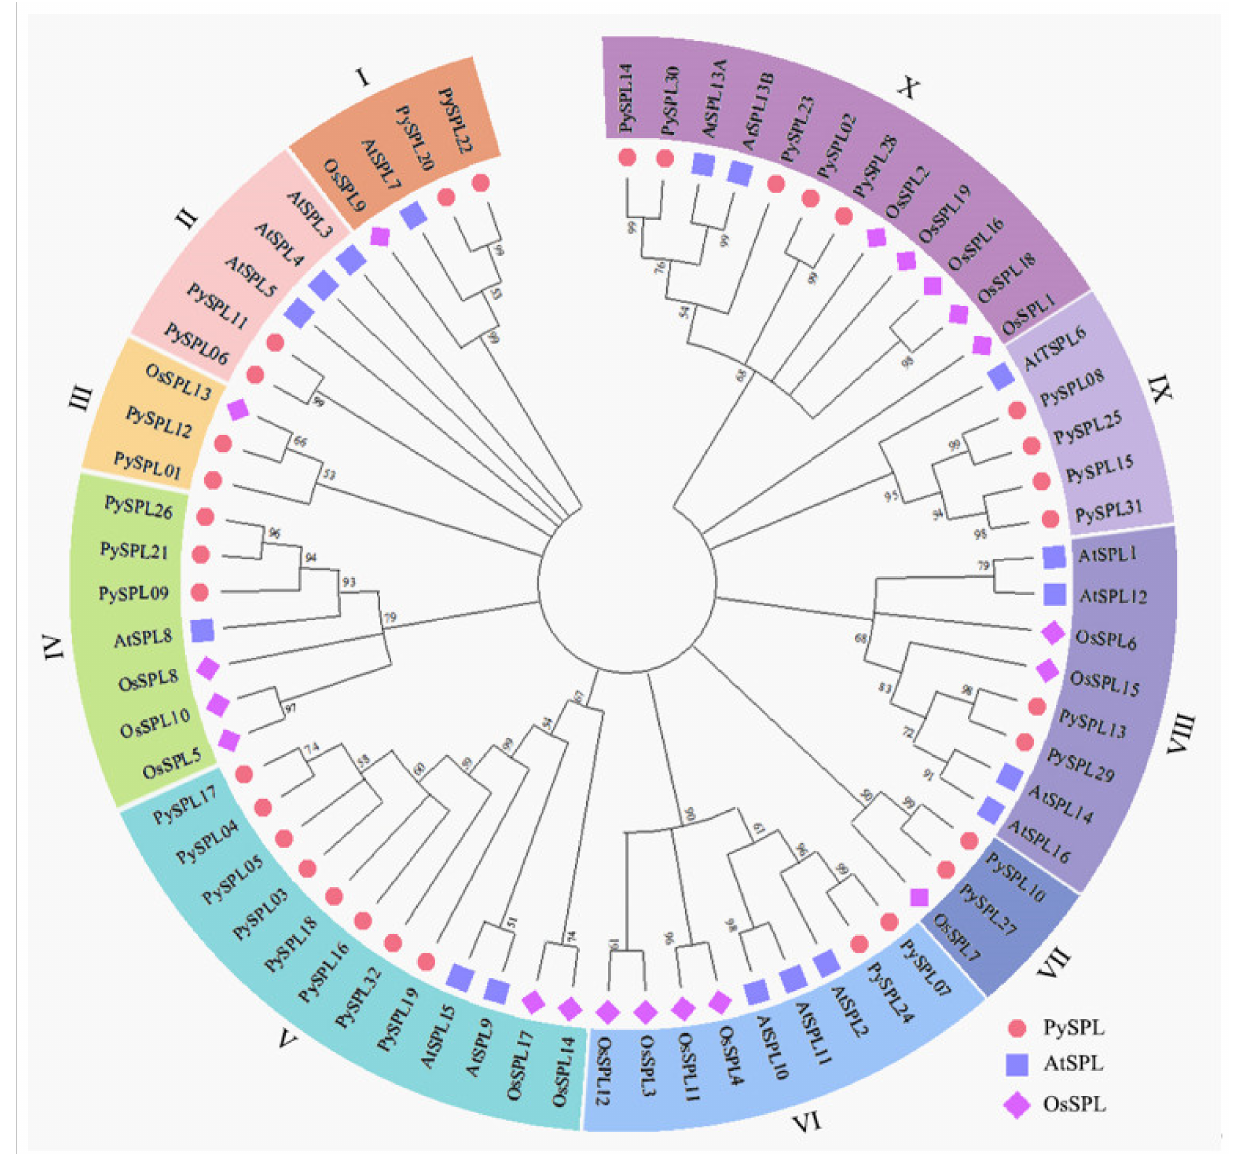
Figure 2. Phylogenetic tree of SPL in Prunus × yedoensis ‘Somei-yoshino’, Arabidopsis thaliana and Oryza sativa. The full-length amino acid sequences of 32 PySPLs , 17 AtSPLs and 19 OsSPLs was used to construct a phylogenetic tree with 1000 bootstrap replicates by MEGA11. PySPLs were divided into subfamilies according to the branch